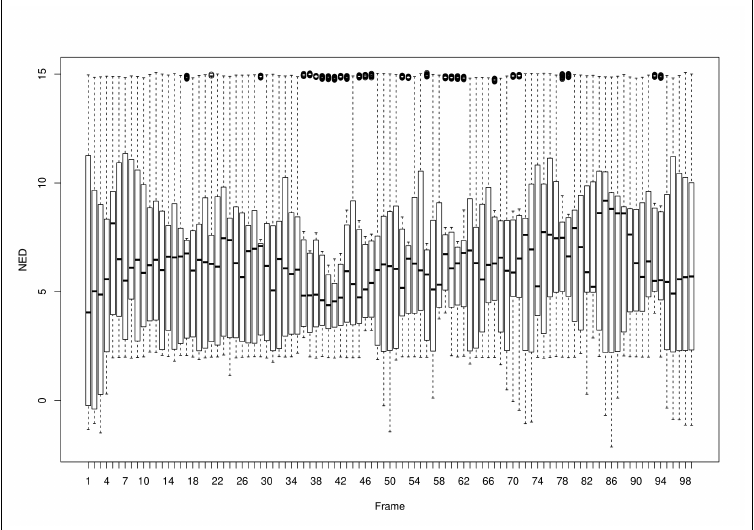
Figure 6. Boxplot of first 100 frames’ NED of audio files for non-congruent